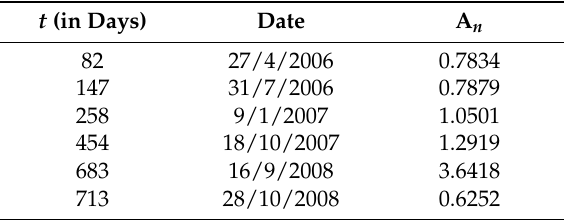
Table 19. Change points for the estimated positive jumps of Microsoft with the corresponding test statistic value.